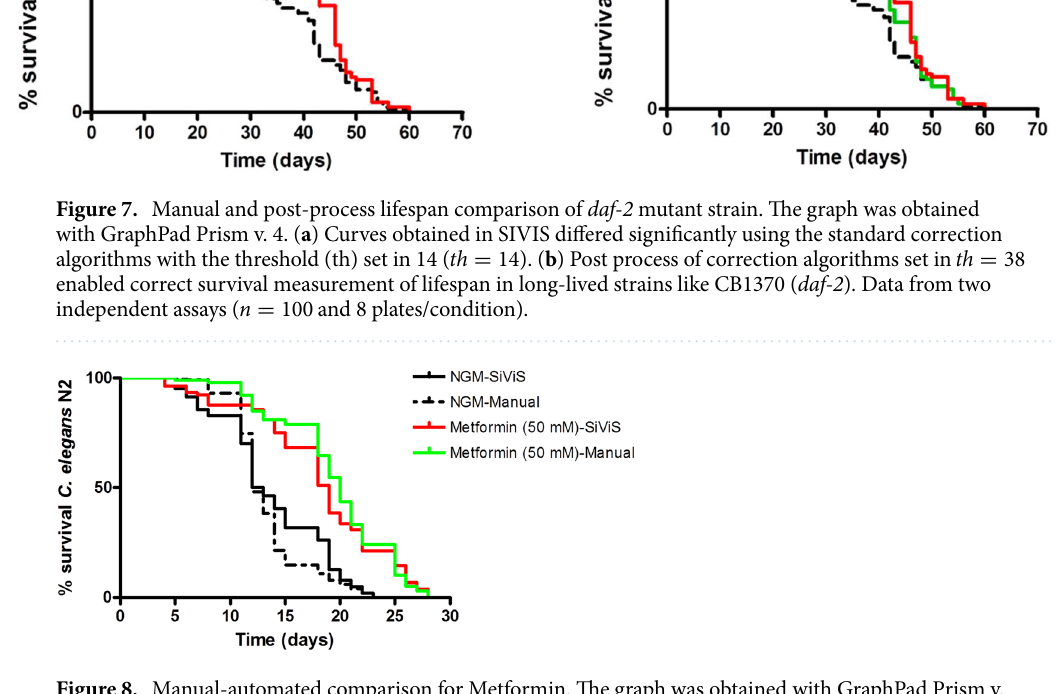
Figure 8. Manual-automated comparison for Metformin. The graph was obtained with GraphPad Prism v. 4. Effect of metformin on C. elegans lifespan measured in manual lifespan assays and in the automated SIVIS system. Data from two independent assays ( n = 100 and 8